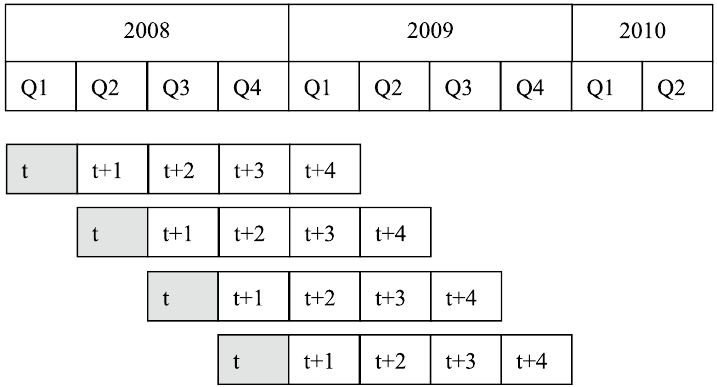
Fig. 2 Rolling formation‑observation process (assuming the formation period is one quarter and the observation period is four